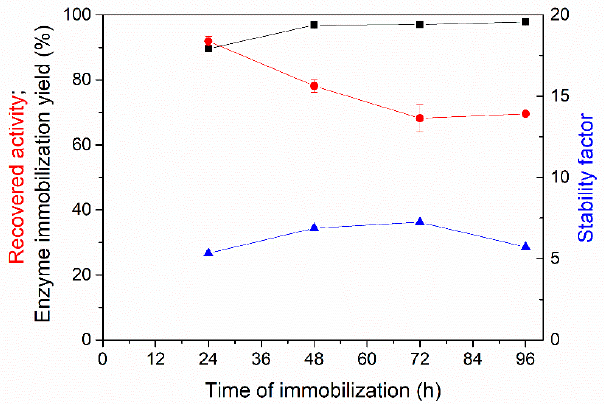
Figure 4. Enzyme immobilization yield ( ■ ), recovered activity ( ● ) and stability factor ( ▲ ) for different immobilization times (20 °C, pH 10.0, protein load 1 mg/g support) of NPD on